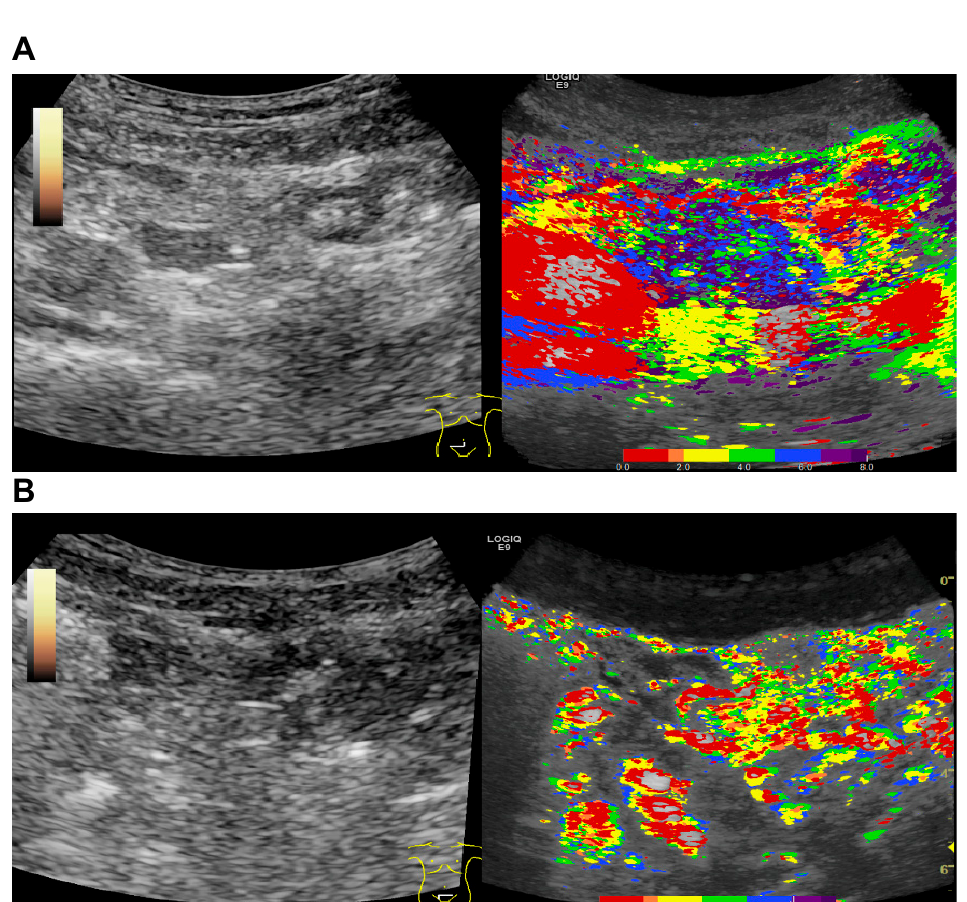
Figure 4. Evaluation of treatment success with parametric imaging of CEUS. B-mode and parametric images of CEUS were evaluated ( A ) before and ( B ) 4 weeks after treatment initiation. In comparison with A, B shows a regression of arterial hyperenhancement reflected by the change of color coding to the higher degree green and blue nuances and the diminished amount of red and yellow and reduced occurrence of transmural